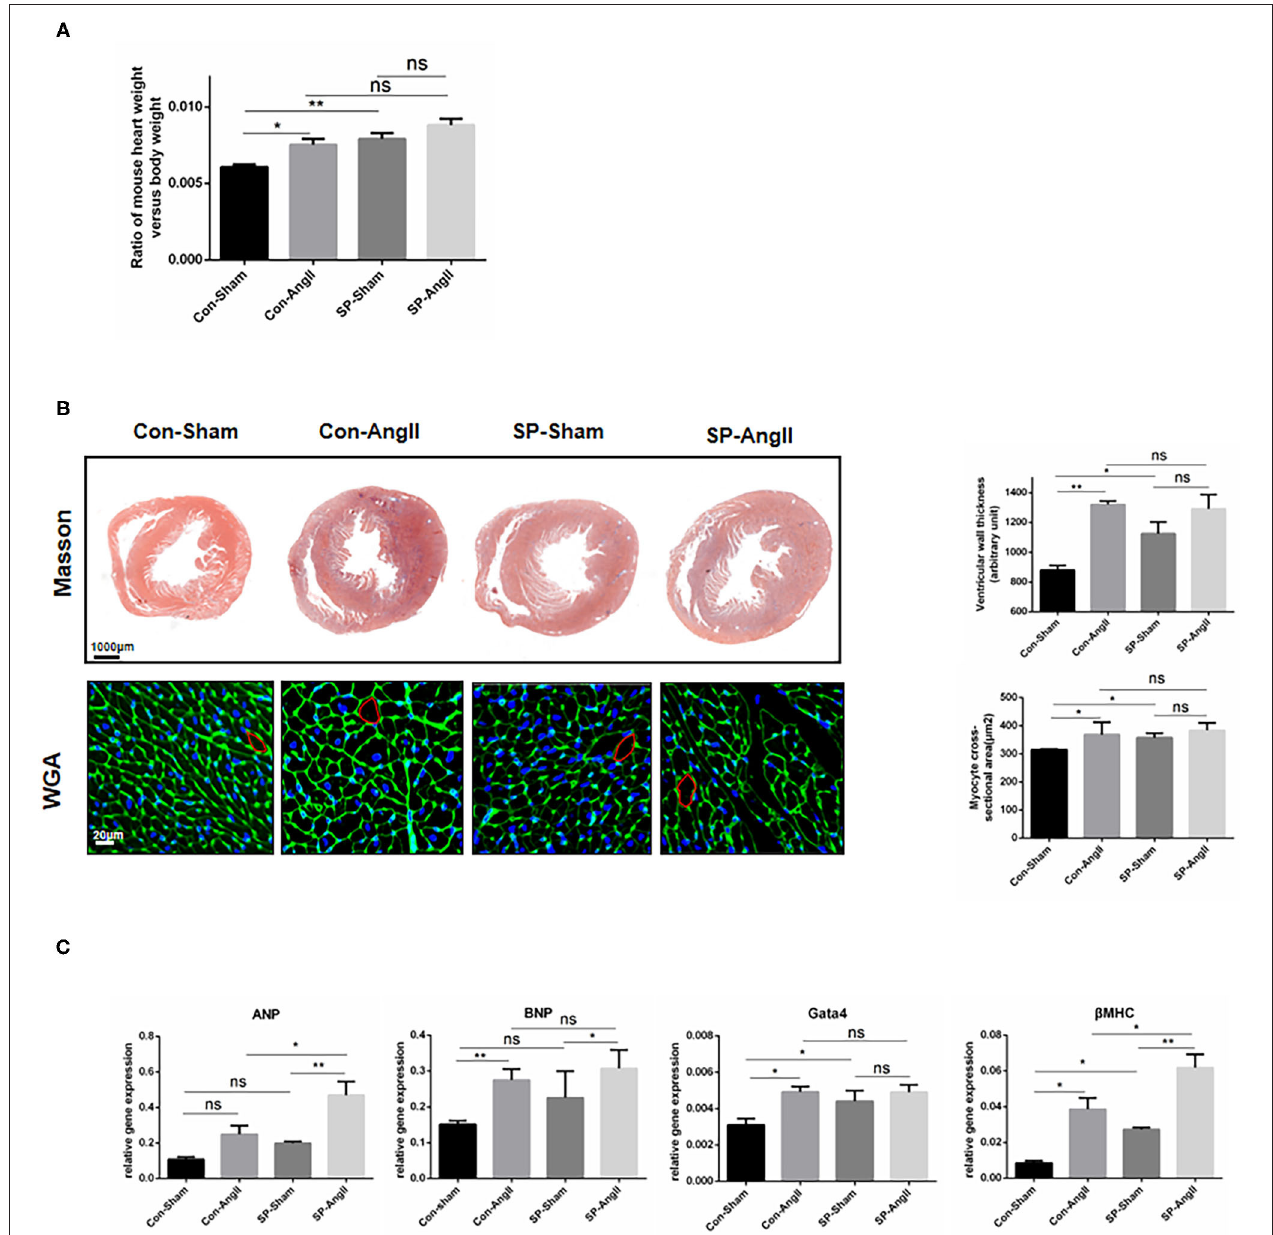
FIGURE 2 | Cardiac fibroblast-specific PGC-1 α KO aggravates cardiac hypertrophy. (A) Quantitative analysis of the ratio of the weight of mouse heart to body weight. (B) Representative cross sections of the heart stained for Masson and WGA. Quantitative analysis of the thickness of ventricular wall (Masson staining) and cardiomyocyte size (WGA staining). (C) qPCR analysis of mRNA expression levels of hypertrophic markers (ANP, BNP, Gata4, β MHC). N.S. indicates no significant difference. * p < 0.05, ** p < 0.01. Data represent mean ± SEM ( n = 5 per